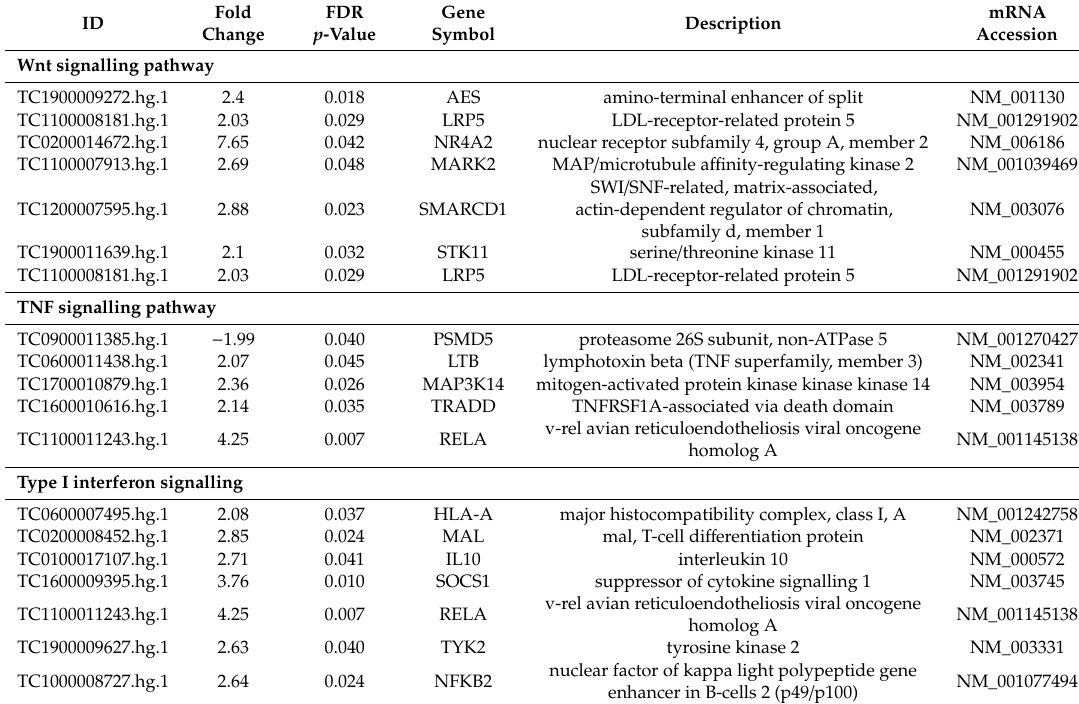
Table 2. Selected signalling pathways involving genes modulated in